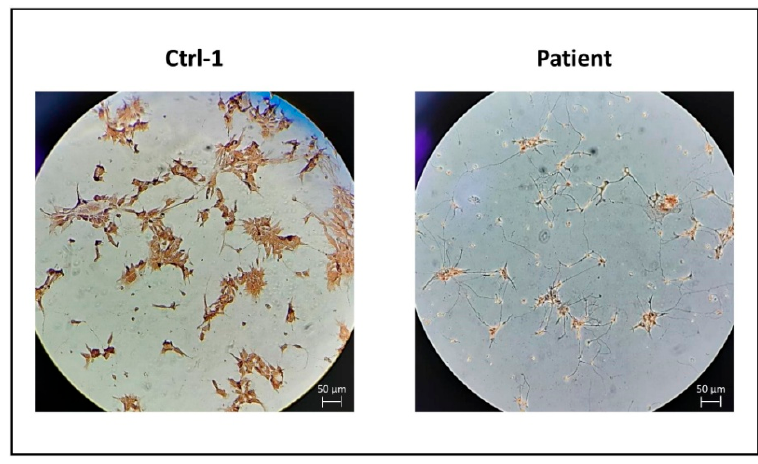
Figure 5. DAB staining for GDAP1, in MNs from Ctrl-1 and patient. Scale bar = 50µm.